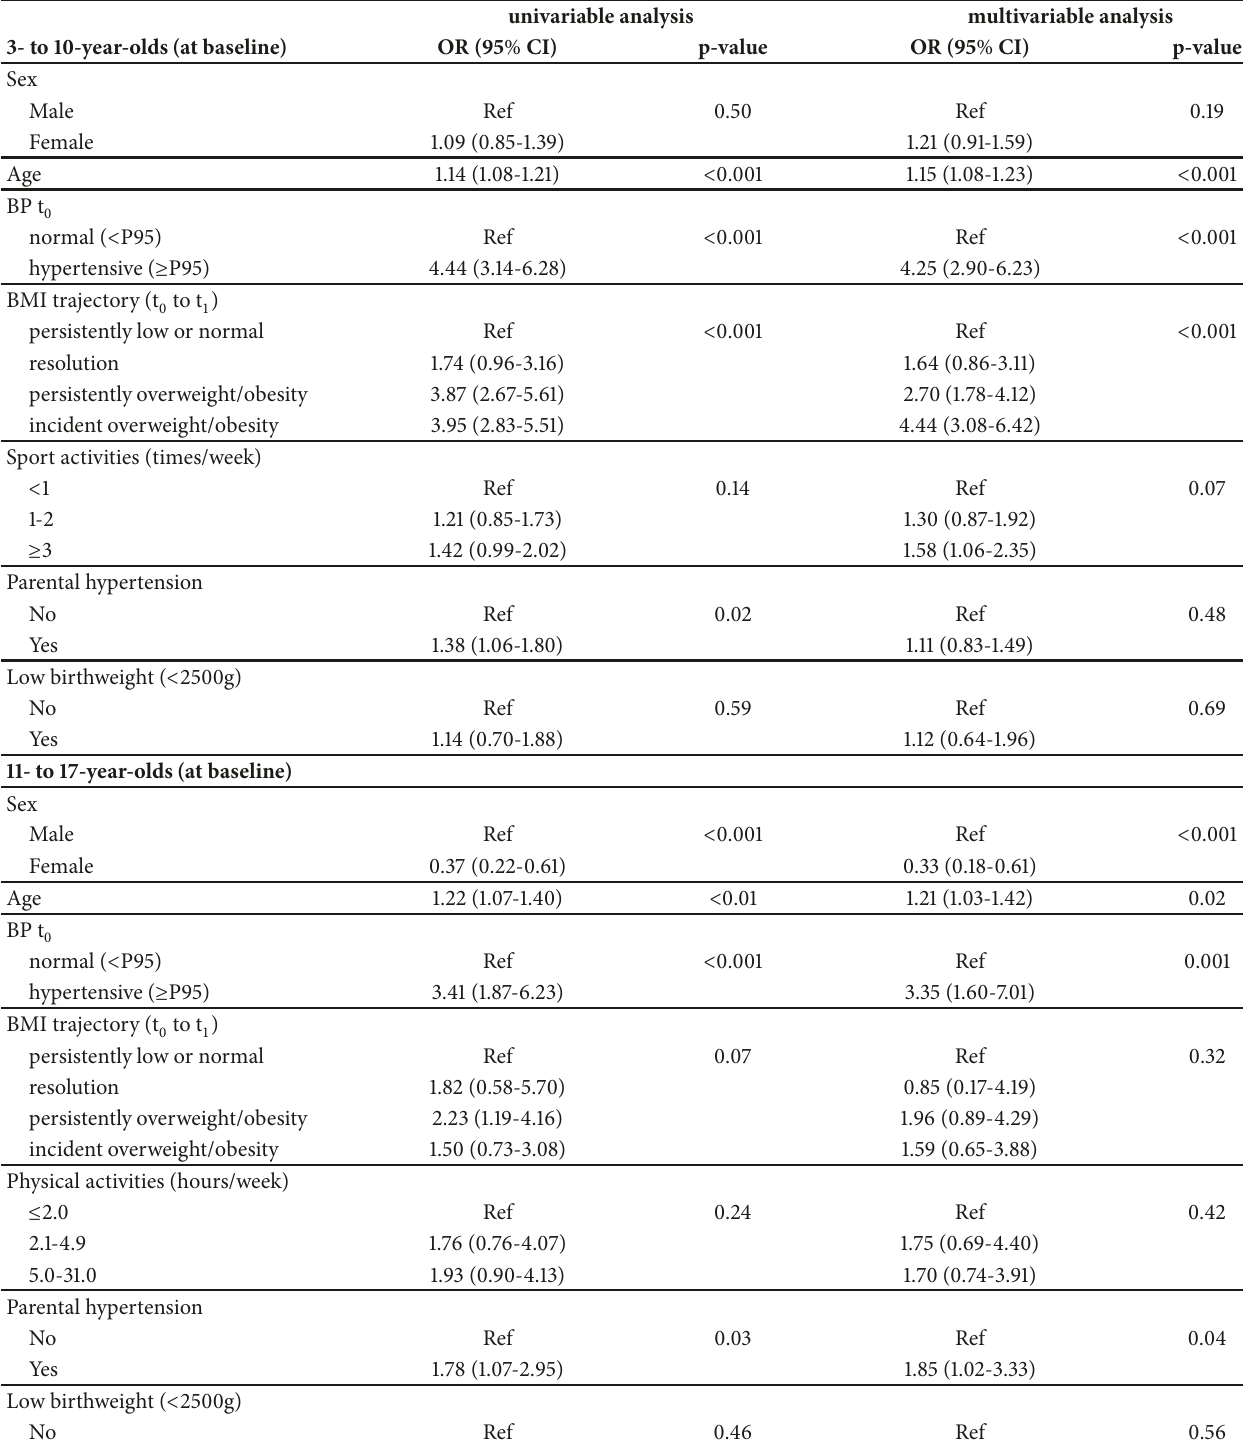
Table 3: Predictors of hypertensive BP ∗ at six-year follow-up in children and adolescents in Germany. univariable analysis multivariable